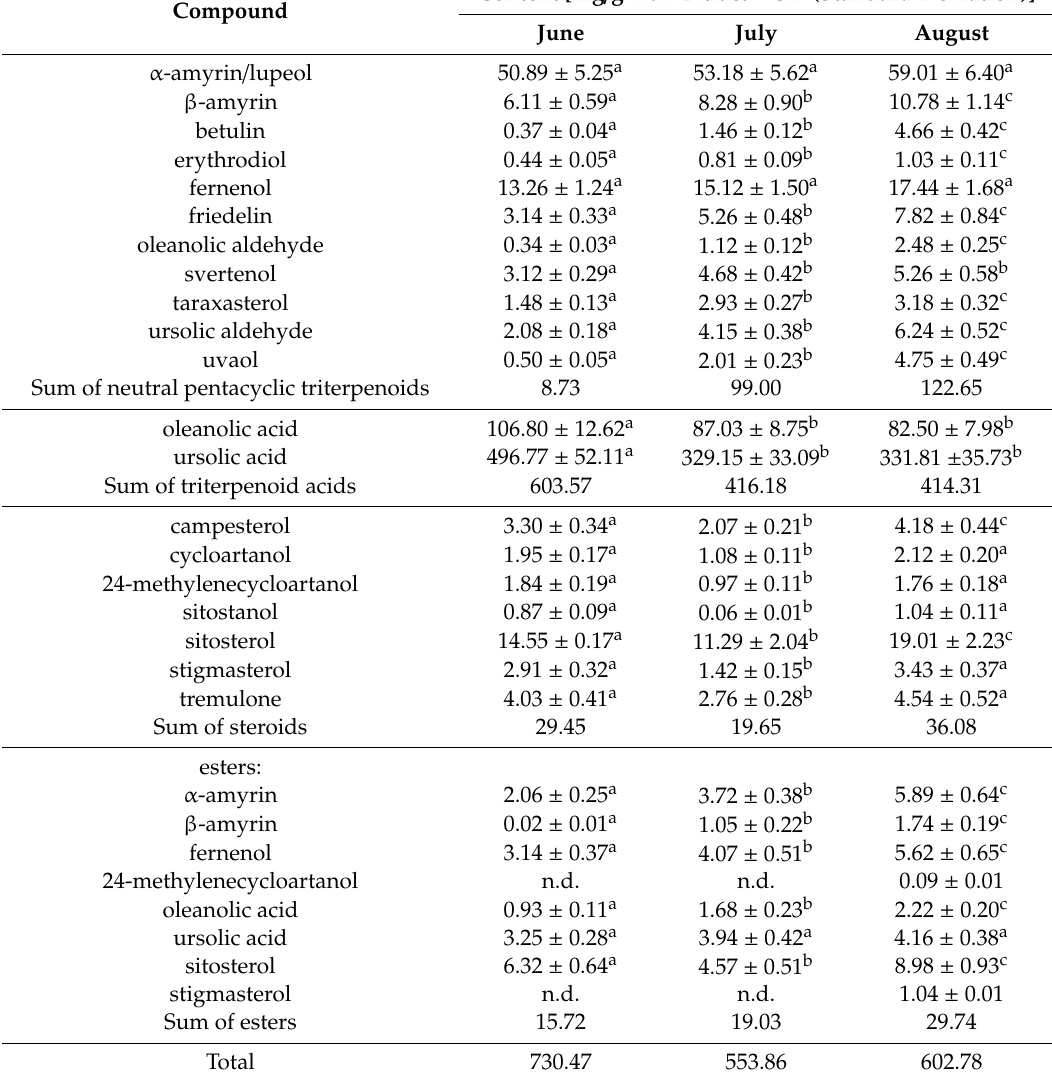
Table 1. Content of triterpenoids in cuticular waxes during lingonberry Vaccinium vitis-idaea fruit